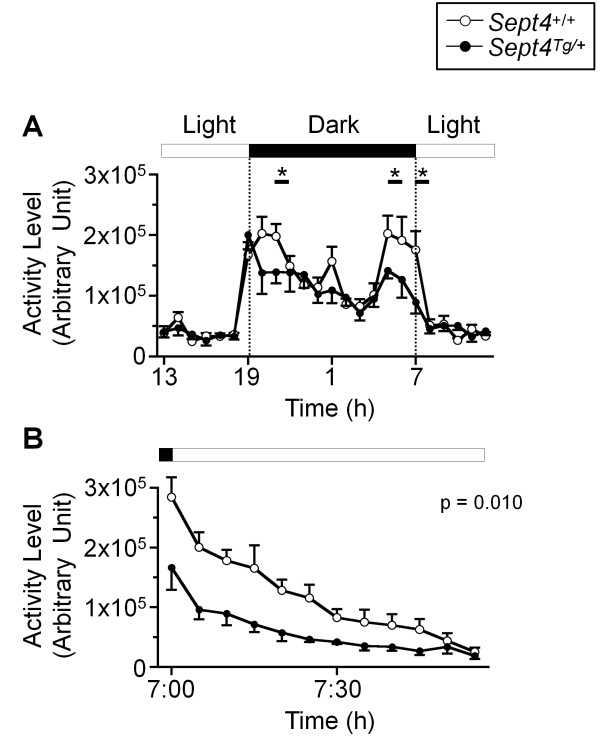
Attenuated diurnal activity surges of Sept4Tg/+ mice. (A) Diurnal oscillation of the locomotor activity in the home cage contained three peaks in Sept4+/+ mice during the dark phase, two of which were significantly attenuated in Sept4Tg/+ mice (*, p = 0.01, n = 9, 6). (B) An expansion of a time block during 7:00–8:00 in 5-min step shows that the significant difference in activity lasted up to 45 min after the onset of the light phase. [F1,14 = 8.77, p = 0.010, genotype × time interaction, F11,154 = 5.26, p < 0.0001].